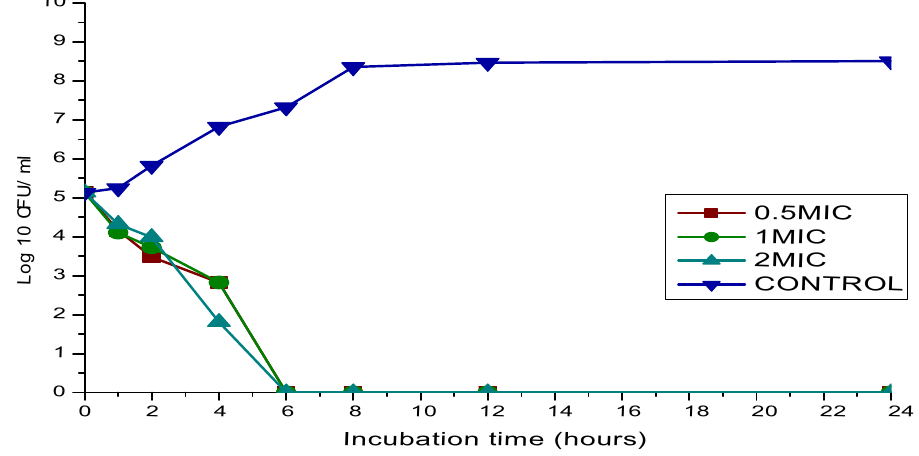
Figure 5. Time kill assay of Ciprofloxacin with Colistin sodium methanesulfonate antibiotics against Acinetobacter baumanni